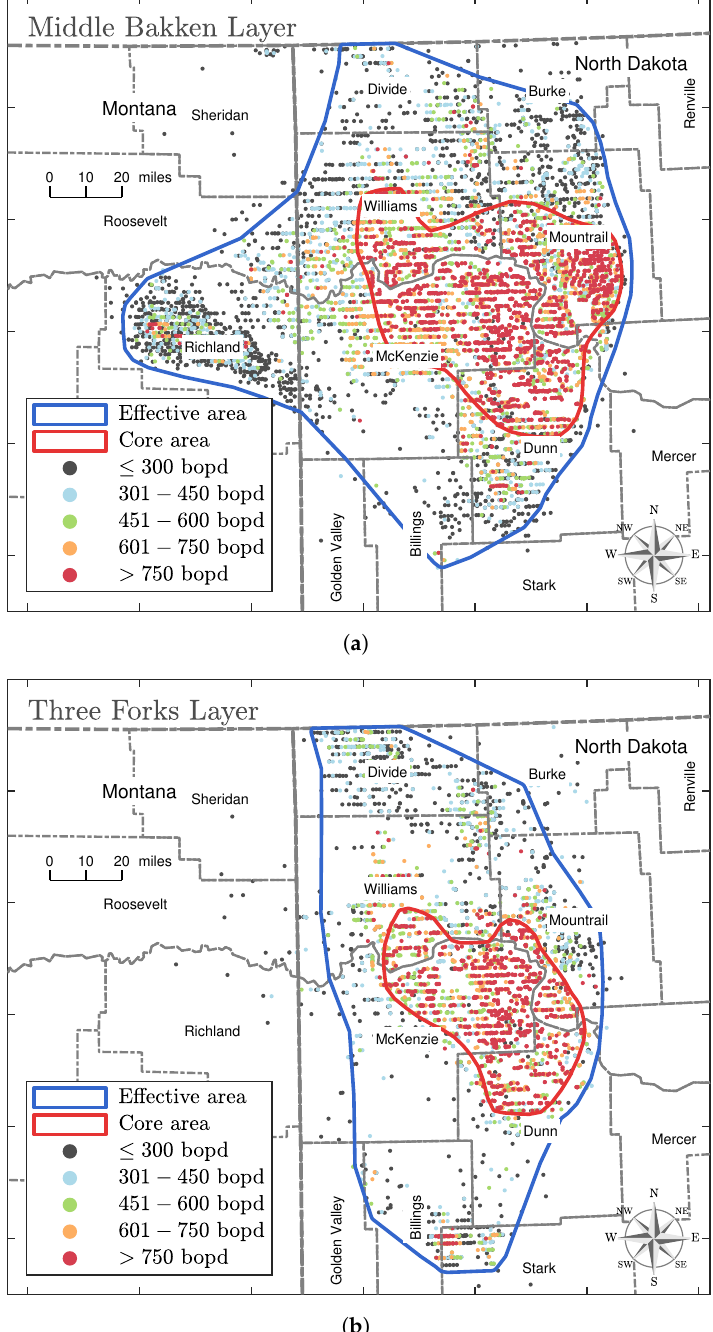
Figure 2. Maps of all 14,678 active horizontal wells completed in the Middle Bakken formation ( a ) and Three Forks formation ( b ) colored by maximum daily oil rate. The red lines define the core areas for each reservoir and delineate best producing wells with more than 750 barrels of oil per day. The blue lines define the effective areas for drilling neglecting a few poor producing wells outside. We define the noncore areas as the difference between the effective and core areas. In the Middle Bakken, there are currently 5732 and 4128 wells located in the core and noncore areas, respectively. The other 2672 and 2146 wells are located in the core and noncore areas of Three Forks,